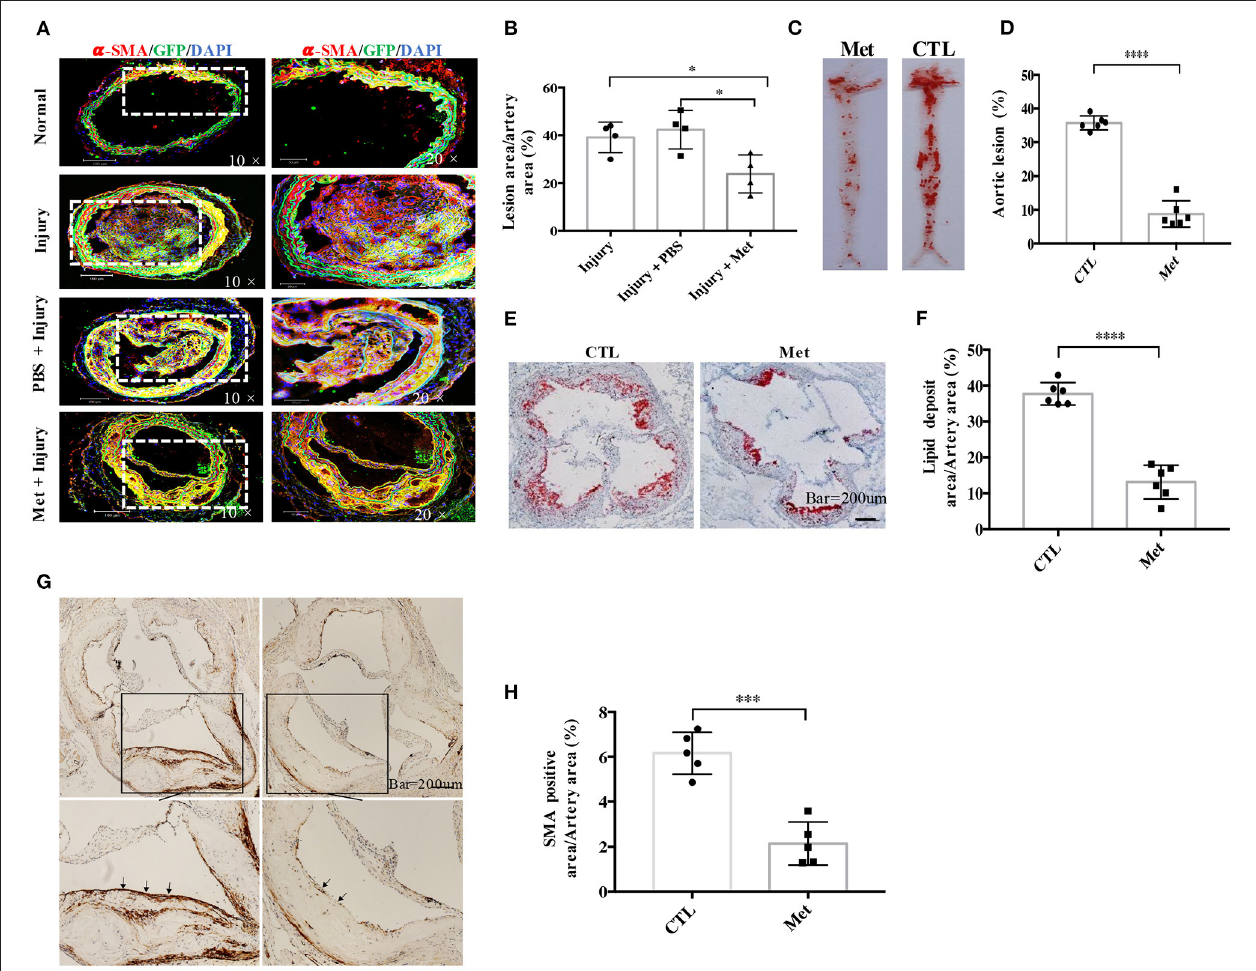
FIGURE 3 | Metformin inhibits medial vascular smooth muscle cell (VSMC) migration in vivo and reduces VSMC infiltration in atherosclerotic plaques in ApoE − / − mice. (A) Myh11cre-eGFP mice were treated with saline or metformin for a week after left carotid wire injury ( n = 5 per group). Representative images of the immunostaining of SMA- and EGFP-positive cells in an artery cross-section. (B) Quantitative analysis of the percentage of lesion area compared to the cross-sectional area of the artery. Data are representative of means ± SEM from five independent experiments. The significance of differences between the series of results was assessed using one-way analysis of variance, followed by a post-hoc comparison with Dunnett’s method for multiple comparisons. * P < 0.05, n = 5. (C) ApoE − / − mice were injected with streptozotocin for 5 days to induce diabetes and then fed with high-fat diet and metformin intervention (Met) or control (CTL) for 8 weeks. The atherosclerotic lesions in the aorta were stained with Oil Red O. (D) Quantification of the en face lesion area in the aorta. The significance of differences was assessed using one-way analysis of variance, followed by a post-hoc comparison with Dunnett’s method for multiple comparisons. **** P < 0.0001, n = 6. (E) Oil Red O staining of atherosclerotic lesions at the aortic root. (F) Quantification of the lesion size in the aortic root. The significance of differences was analyzed using one-way analysis of variance, followed by a post-hoc comparison with Dunnett’s method for multiple comparisons. **** P < 0.0001, n = 6. (G) Immunochemistry staining of α -SMA in the aortic root. (H) Quantitative analysis of α -SMA-positive area in the aortic root. The significance of differences between series of results was assessed using one-way analysis of variance, followed by a post-hoc comparison with Dunnett’s method for multiple comparisons. *** P < 0.001, n =